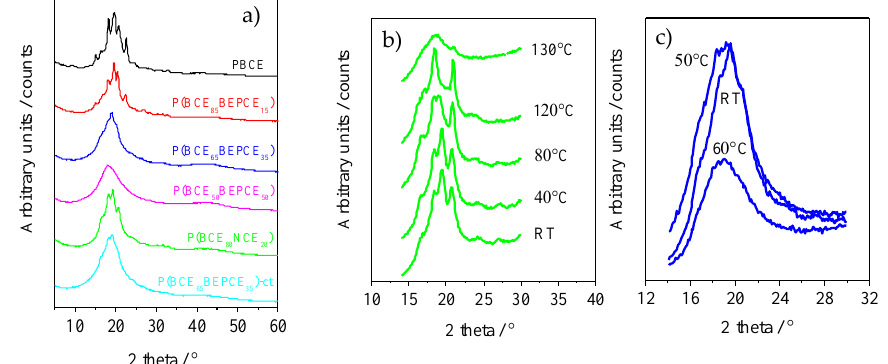
Figure 6. ( a ) XRD profiles at room temperature of all the samples under study; ( b ) and ( c ) XRD profiles at different temperatures for the compression molded films of P(BCE 80 NCE 20 ) and P(BCE 65 BEPCE 35 ), respectively.